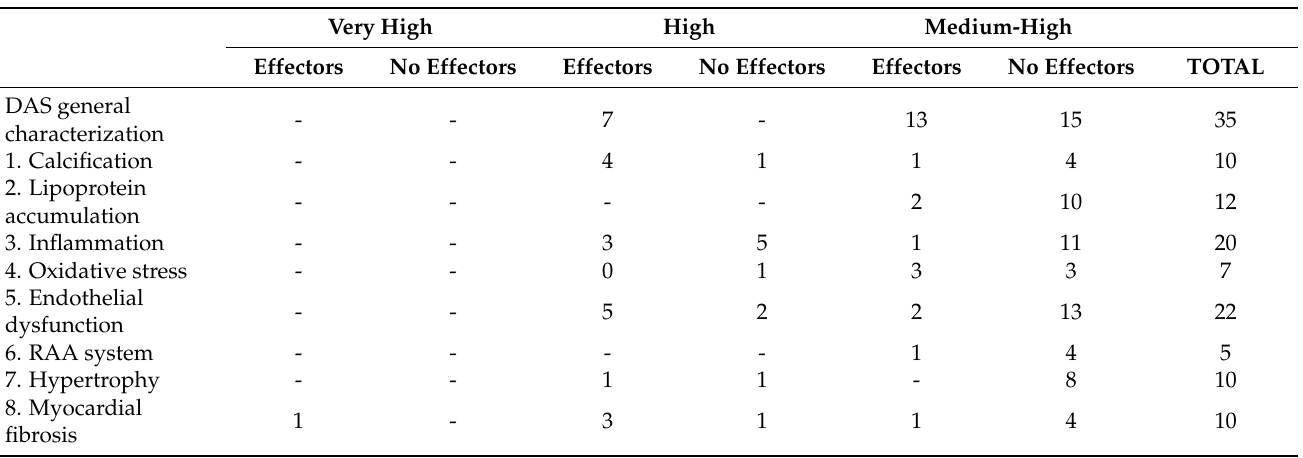
Table 4. Categorization of the ANN score according to the probability of being a true positive result, showing the number of proteins with a strong relationship in each category. DAS, degenerative AS. Very